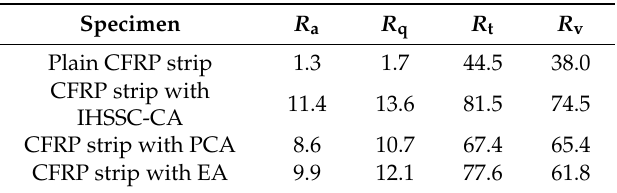
Figure 10. 3-D and 2-D images of topographic surface of plain CFRP strip. Table 3. Roughness parameters ( µ m) of the plain CFRP strip and CFRP strips with different adhesives after application of load.